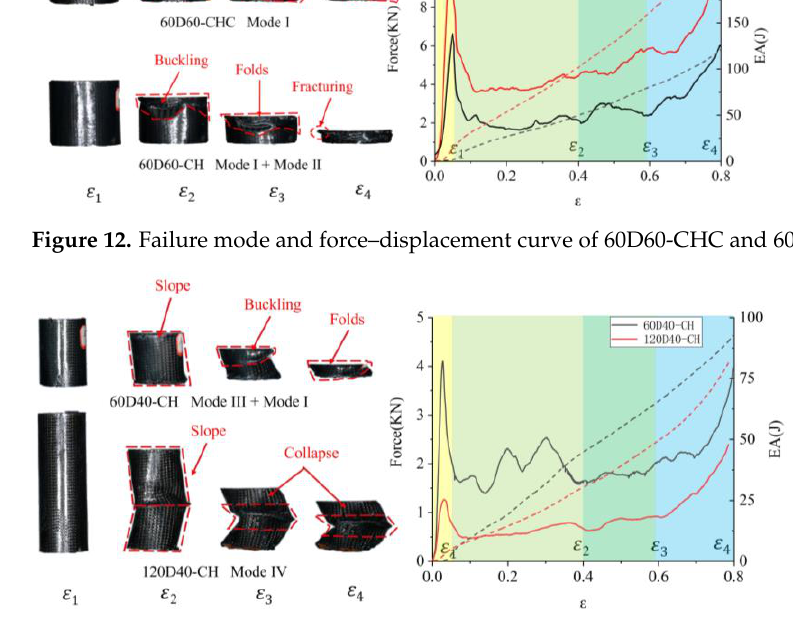
Figure 14. Three failure modes of the thin AHST tube after axial compression. (a) the ring mode, (b) the Z mode and (c) the Mix mode.(d) Detail diagram of the failure modes. Figure 14a shows the ring mode failure of one of the 60D60-CH specimens, and the honeycomb core presented a significant negative Poisson ’ s ratio, which was caused by the cell shrinking. The radius of the middle area of the concave structure was reduced, leading to the interface debonding. As the crushing progressed, there were many shear bands formed on the surface of structures, accompanied by the twisting of cells (Figure 14d). Then, the cells had a high degree of compactness and stably formed a dense layer. It can be seen from the micro-failure modes that the oblique shear band in Mode I was caused by the twisting of cells. In the ring mode, the tube wall was folded progressively, but due to the negative Poisson ’ s ratio effect, the size of the folded cells in the structure was incon- sistent. As shown in Figure 14b, in this crushing process of one of the 120D60-CH specimens, the response of the CFRP face was controlled by the combination of collapsing of the hon- eycomb core and debonding of the interface. In addition, core debonding occurred as the bonding layers were not strong enough to transmit the constraints of the honeycomb cores. The cells had a low degree of compactness due to the cells not only having the in-